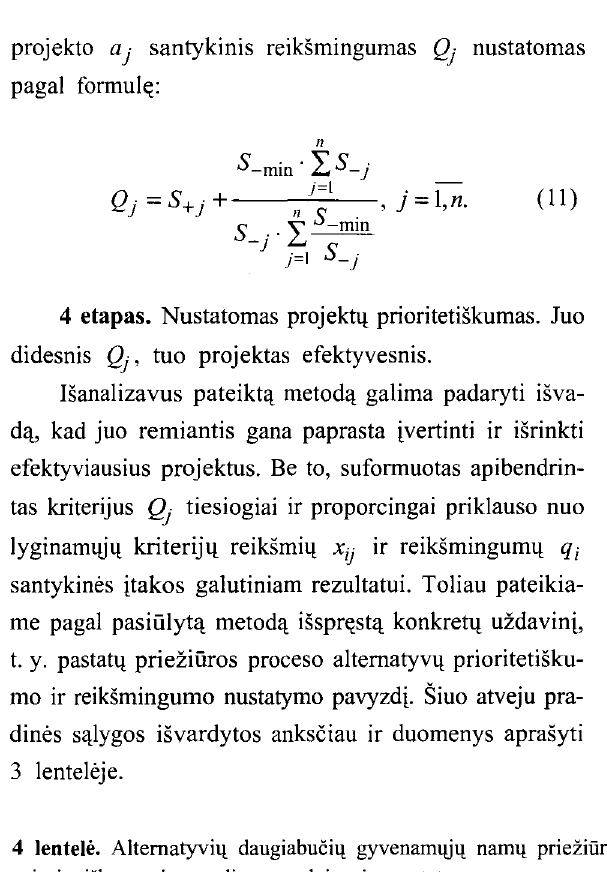
Table 4. Dwelling facilities process alternatives multiple criteria analysis results and determination of the priority and utility degree of